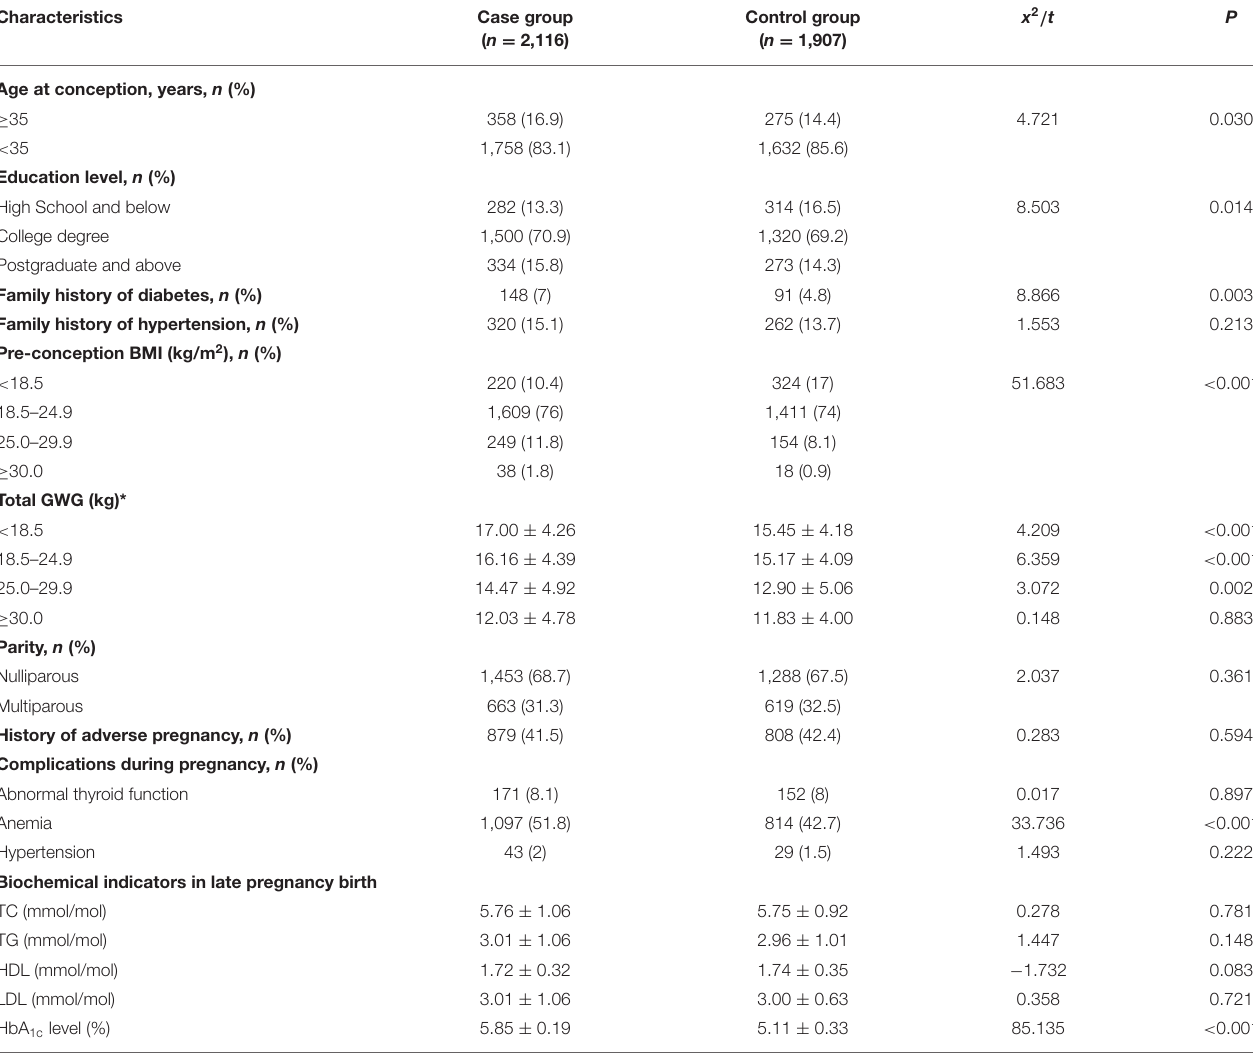
TABLE 1 | Basic characteristics of participants according to late pregnancy HbA 1c categories.